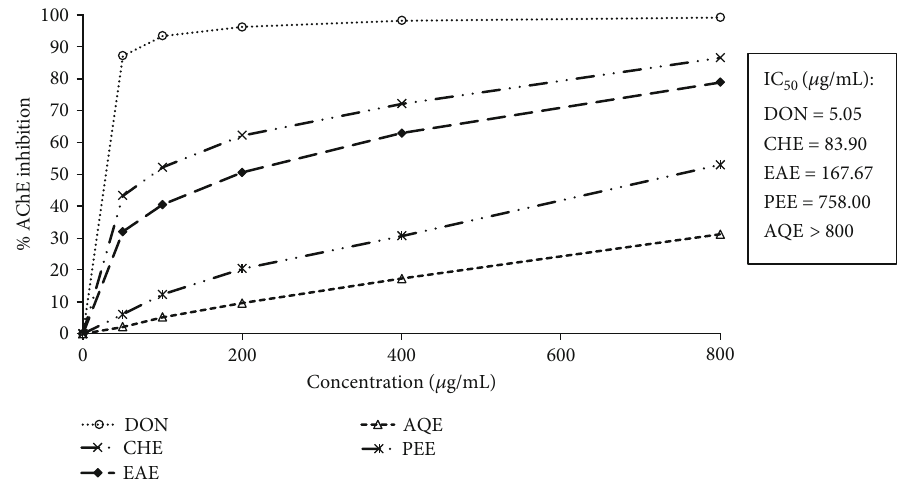
Figure 1: Inhibition of acetylcholinesterase by di ff erent extracts of E . fl uctuans . Results represent mean ± SD ( n = 3 ). Donepezil (DON) was used as a reference compound. CHE: chloroform extract; EAE: ethyl acetate extract; AQE: aqueous extract; PEE: petroleum ether extract; AChE: acetylcholinesterase.